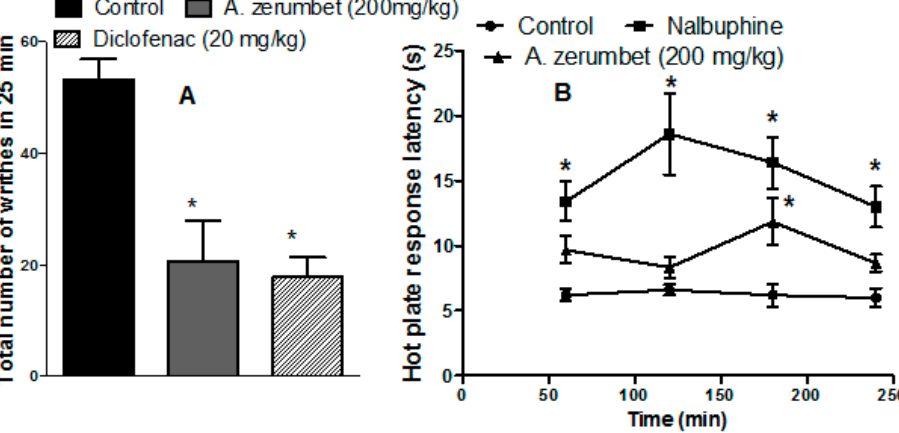
Figure 8. ( A ) Effect of treatment with A. zerumbet extract in a dose of 200 mg/kg, p.o., or diclofenac (20 mg/kg, p.o.) on acetic acid-induced writhing (0.7%, 1 mL/100 g) in mice. ( B ) Hot plate response latency (s) detected 1–4 h following administration of vehicle, extract (200 mg/kg, p.o.) or the reference standard, nalbuphine (10 mg/kg, p.o). Data is presented as mean ± S.E.M. (n = 5–8). * p < 0.05 vs. control values.